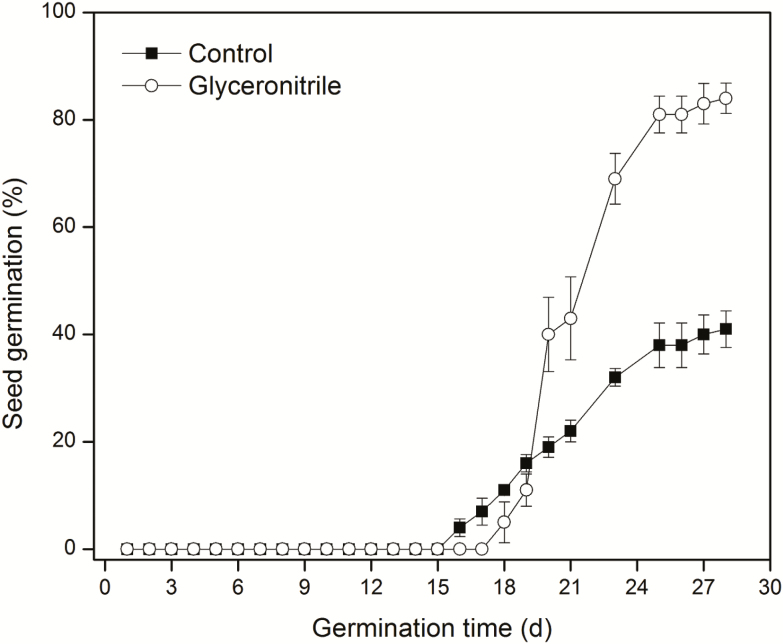
Germination dynamics (mean % ± SE) of fresh Anigozanthos flavidus seeds incubated at 15 °C in a 12/12 h light/dark regime during 28-day incubation in Petri dishes containing 0.7 % (w/v) water agar (control, black square) or water agar containing 50 μM glyceronitrile (white circle). Four dishes of 25 seeds were used for each treatment.